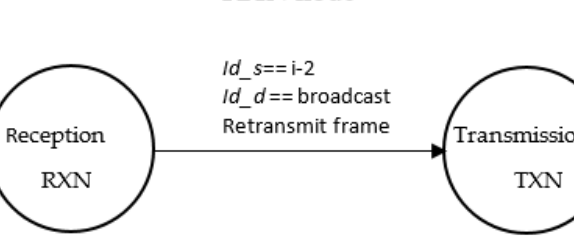
Figure 11. TXN node state diagram.